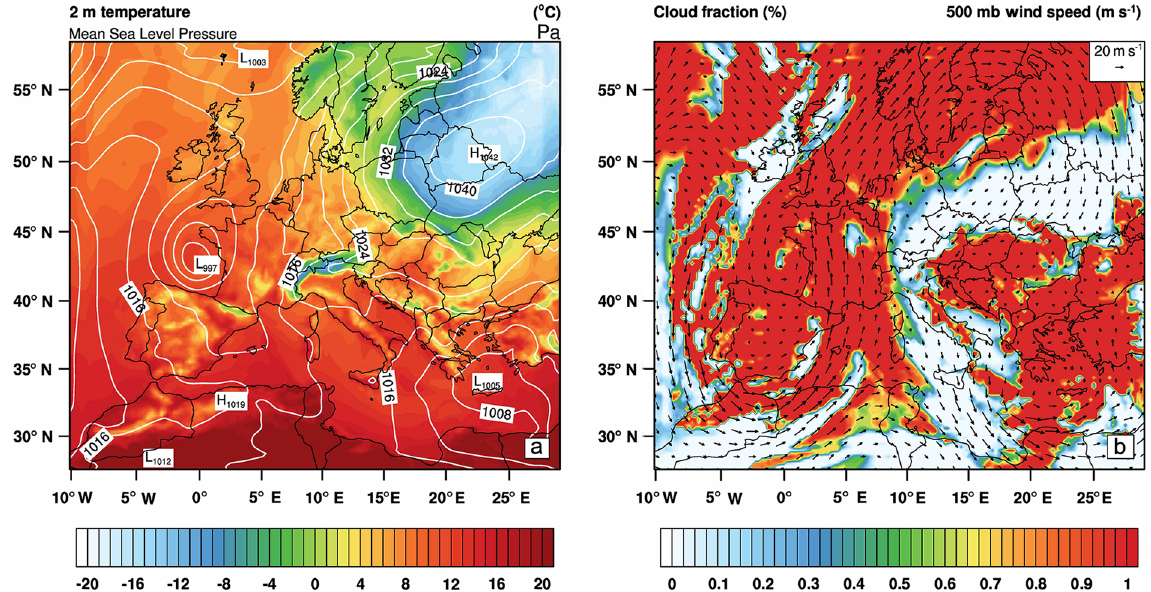
Figure 2. Model synoptic conditions for 17 February 2007 at 12:00UTC: (a) surface pressure in contours and 2m temperature ( ◦ C) as color shading, (b) 500mb wind vectors and total cloud area fraction as color shading.